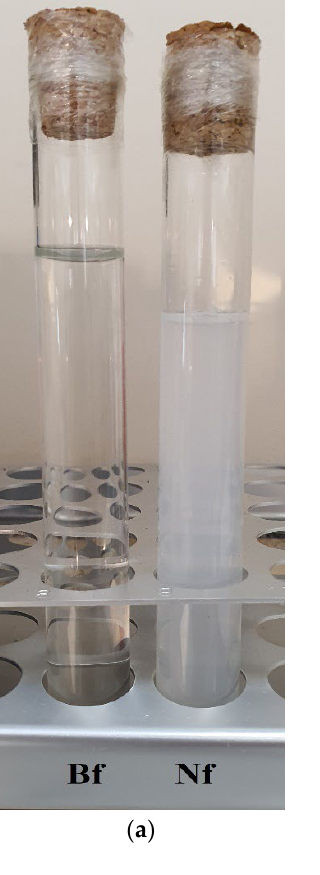
Figure 4. ( a ) Appearance of base fluid (deionized water) and fraction of 0.1% Al 2 O 3 -H 2 O nanofluid